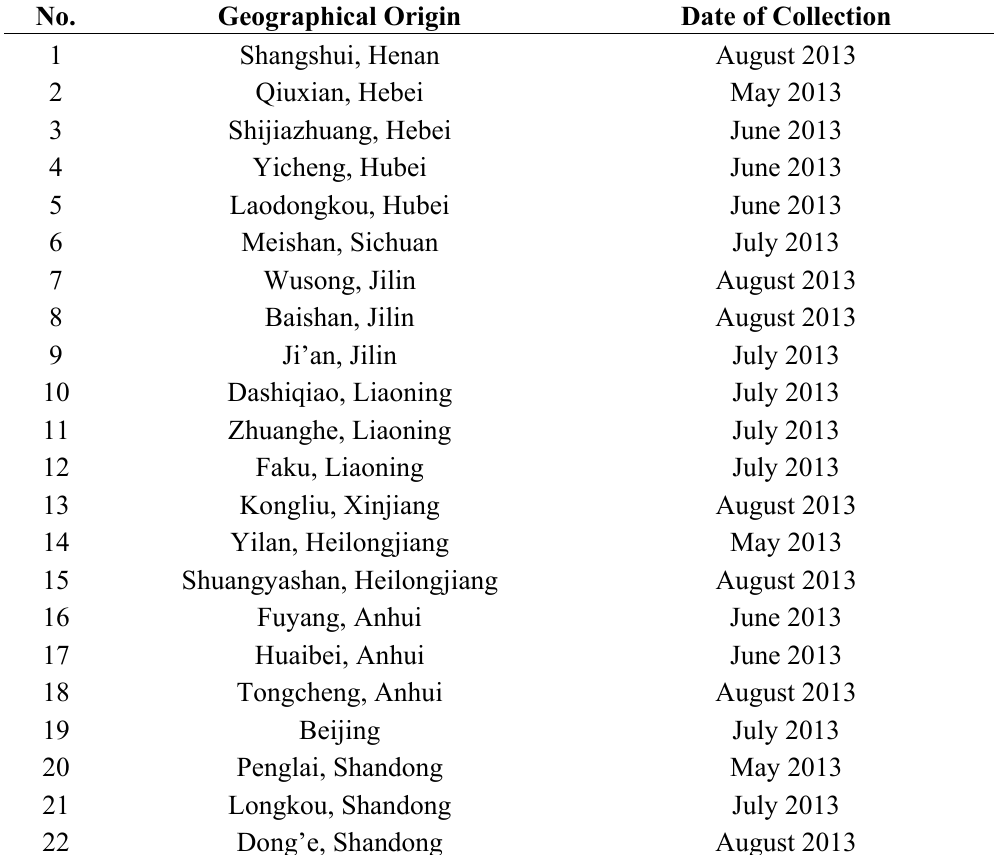
Table 2. The geographical origins and collection time of poplar type